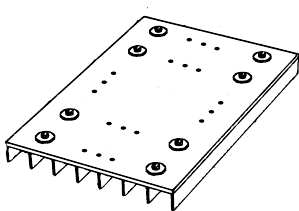
Figure 6. Hypothetical illustration of the m × n matrix arrangement on rectangular